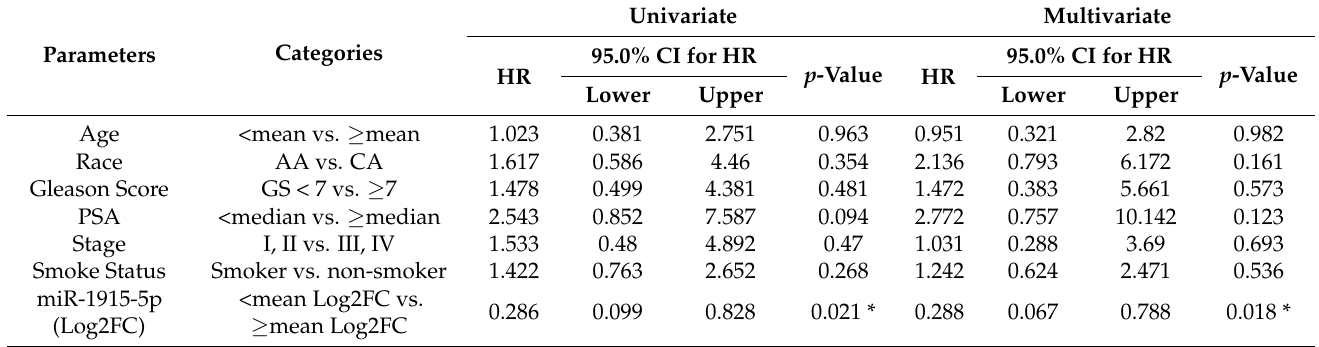
Table 6. Univariate and multivariate Cox regression analysis assessing the association of the sEV-associated miRs as well